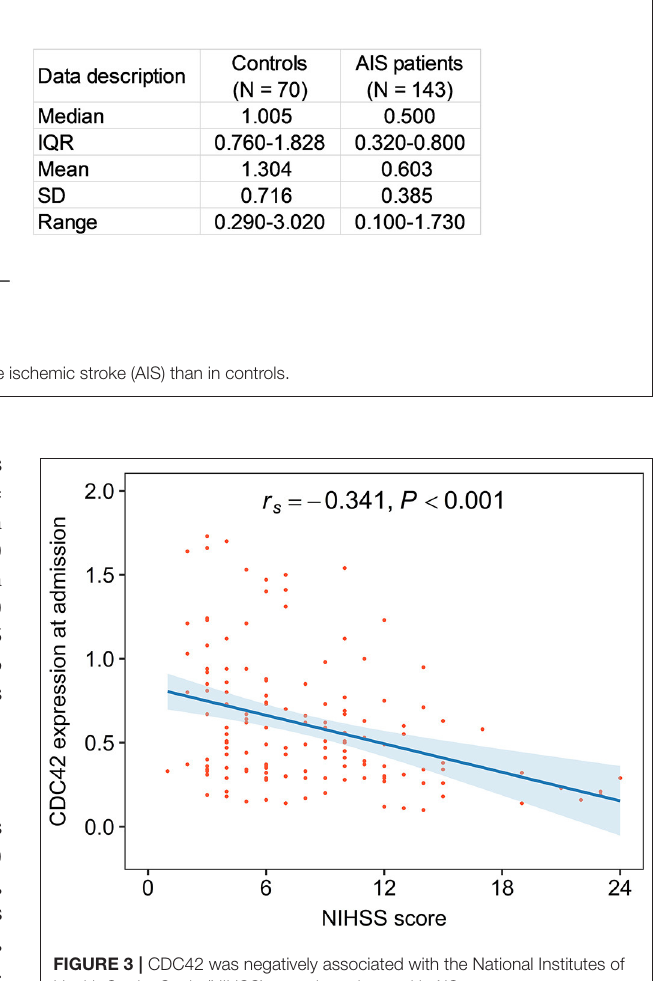
FIGURE 3 | CDC42 was negatively associated with the National Institutes of Health Stroke Scale (NIHSS) score in patients with